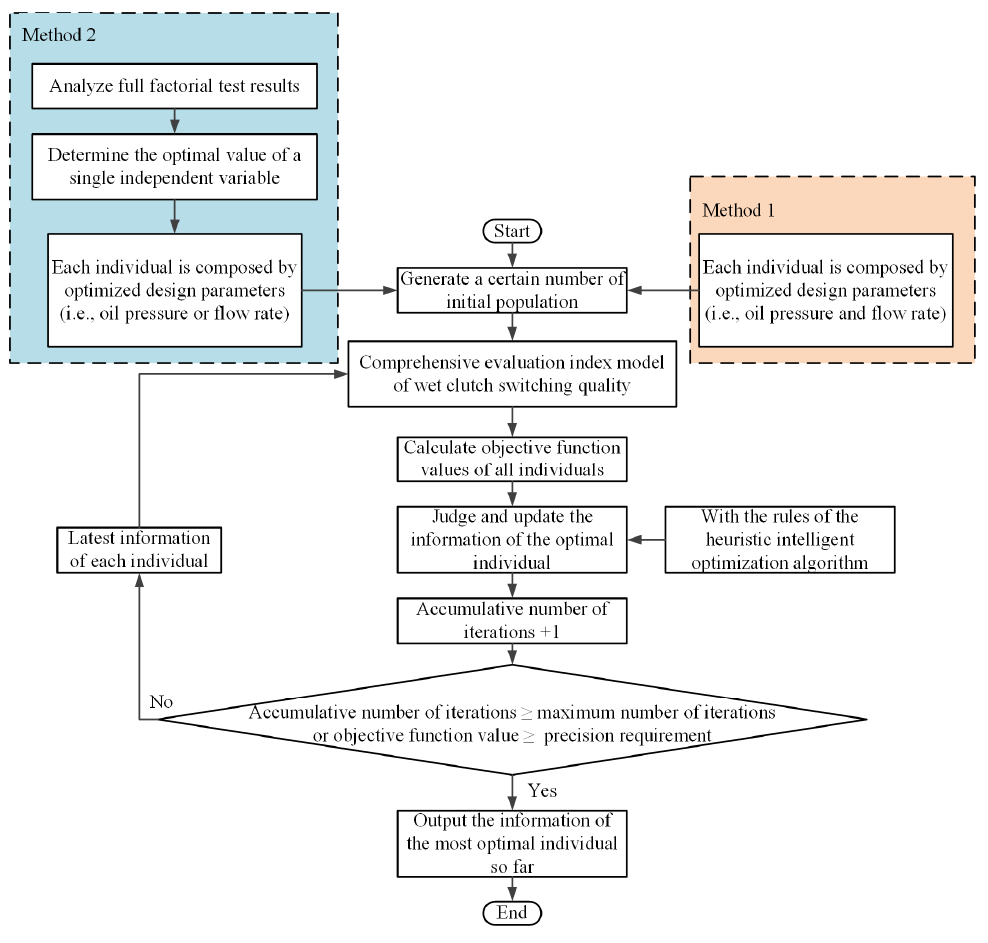
Figure 5. Flow chart of Methods 1 and 2.